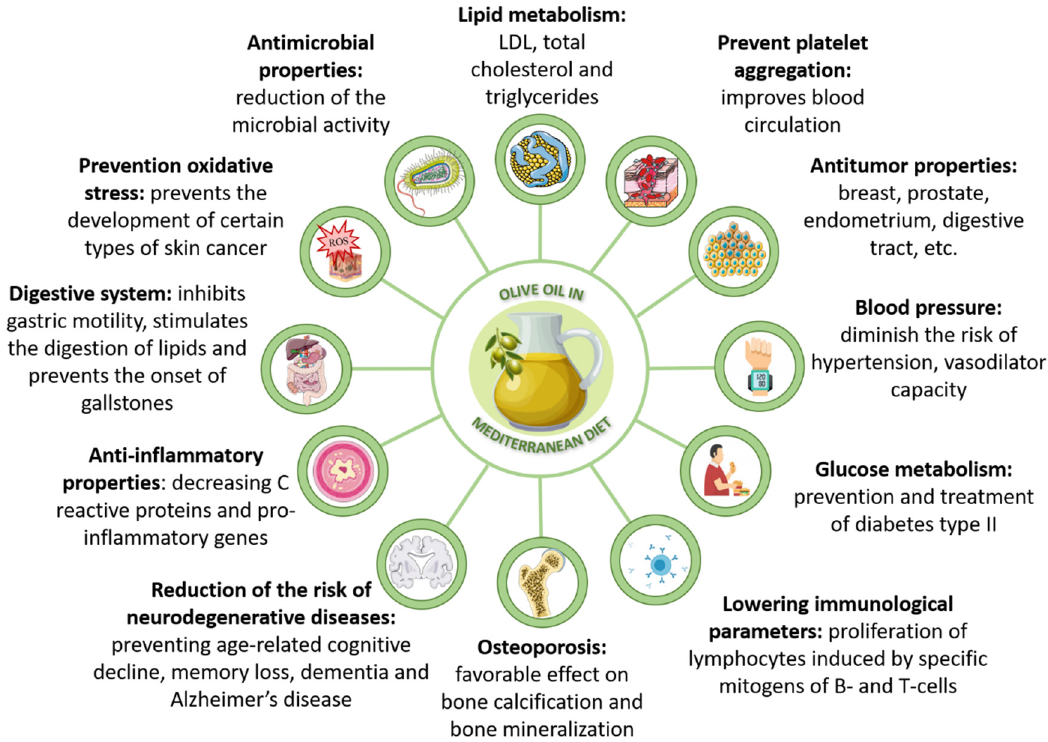
Figure 1. Scheme of the beneficial and healthy effects of the olive oil inclusion in the Mediterranean diet. Information adapted from [11,12].